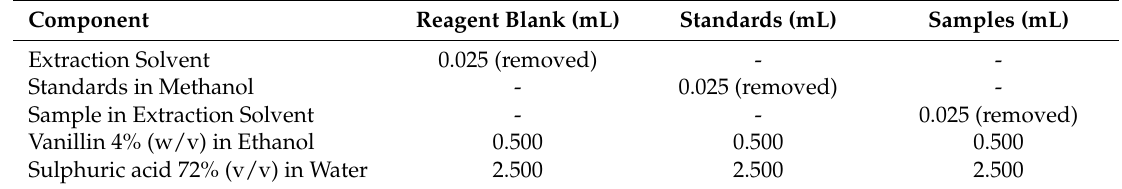
Table 4. The modified vanillin-sulphuric acid assay setup